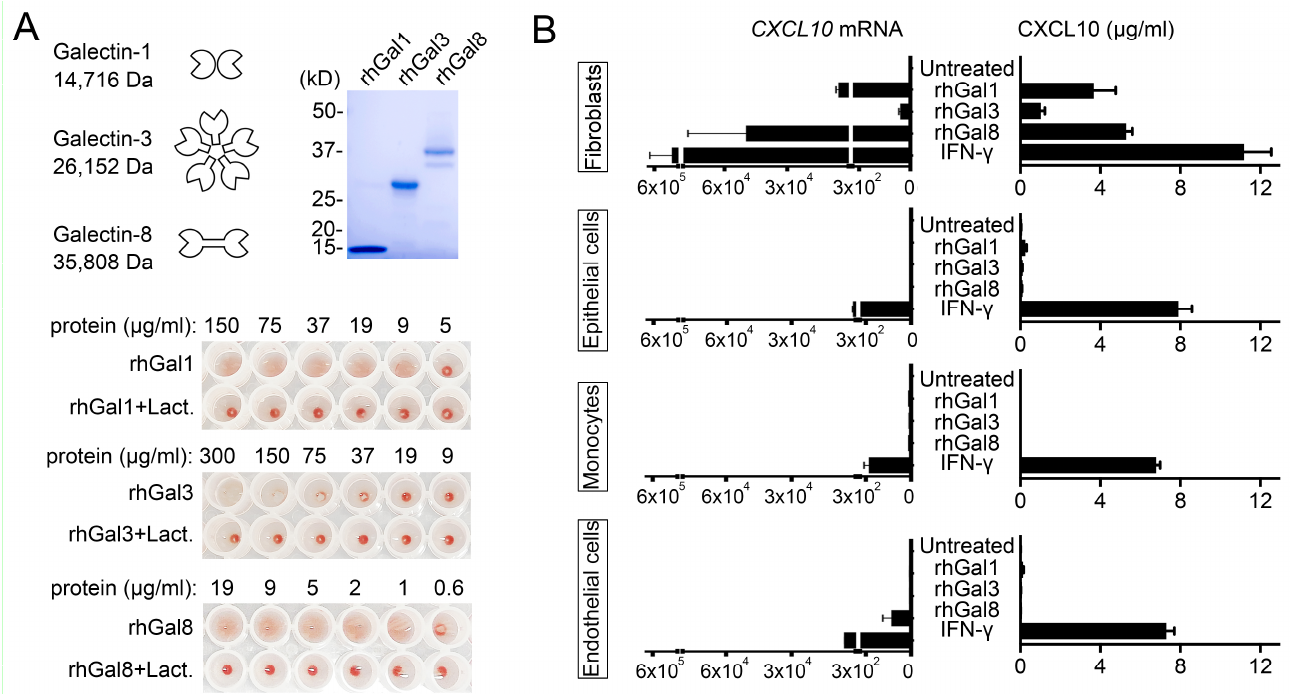
Figure 1. Galectins induce CXCL10 in a cell type-specific manner. ( A ) SDS-polyacrylamide gel electrophoresis of recombinant human galectins (rhGal) stained with Coomassie Blue. Molecular weights of protein standards are indicated on the left. The hemagglutination assay was performed using serial two-fold dilutions of the recombinant protein. The bottom row contains protein incubated with β -lactose, a competitive carbohydrate inhibitor of galectin binding. ( B ) Cultures of human corneal fibroblasts, human corneal epithelial cells, THP-1 monocytes and human umbilical vein endothelial cells (HUVECs) were incubated with 50 µg/mL rhGal-1, -3 and -8 or 50 µg/mL IFN- γ . Quantitative real-time PCR was used to determine the levels of CXCL10 mRNA after 6 h of incubation ( n = 3 independent experiments), whereas ELISA was used to determine the levels of CXCL10 protein in cell culture supernatants after 24 h of incubation ( n = 6 independent experiments). The data represent the mean ± SEM.